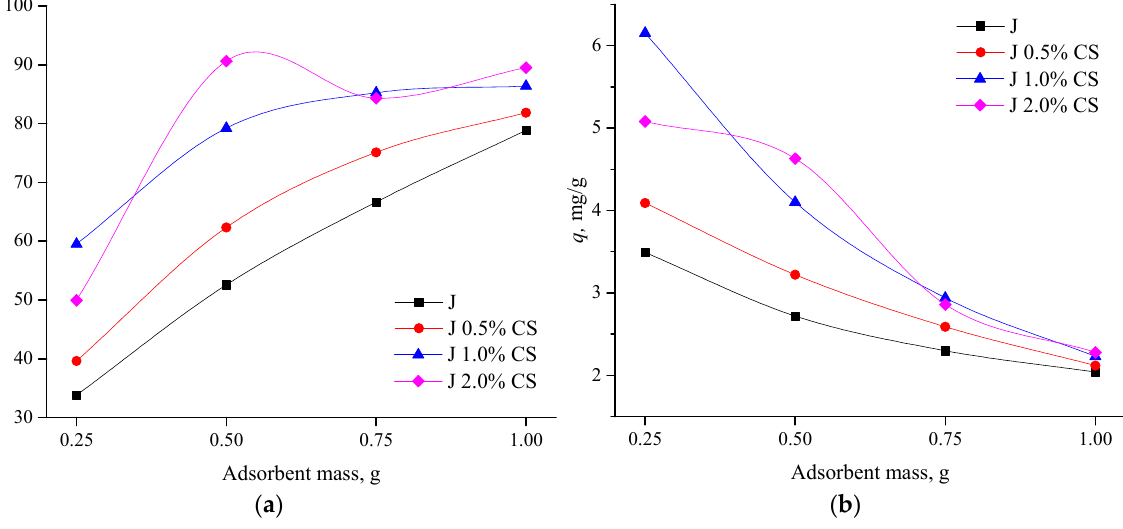
Figure 7. The effect of adsorbent mass on: ( a ) RO 16 removal ( R ) and ( b ) adsorption potential ( q ) of studied adsorbents ( c 0 = 25 mg/L, t = 21 h, T = 25 °C, pH of 2.0 (for J, J0.5% CS, and J1.0% CS) and 4.0 (for J2.0% CS), the mass of adsorbent 0.25–1.00 g).